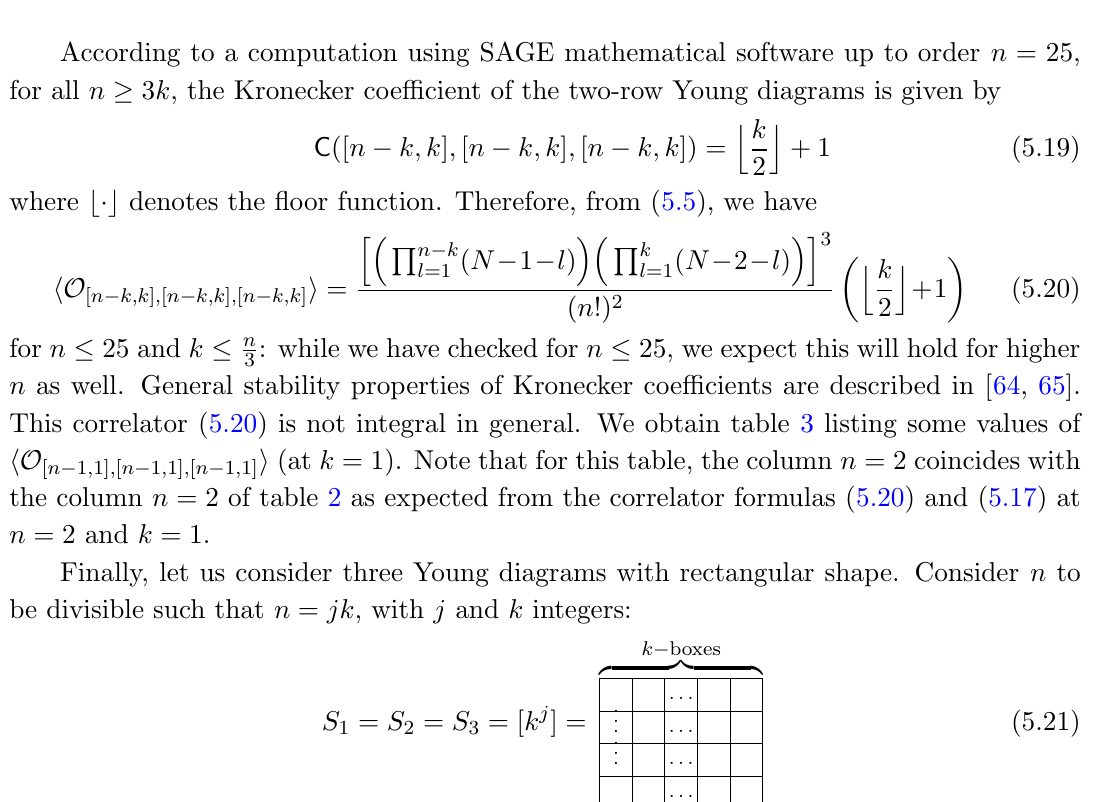
[ n (cid:0) 1 ; 1] ; [ n (cid:0) 1 ; 1] ; [ n (cid:0) 1 ; 1]